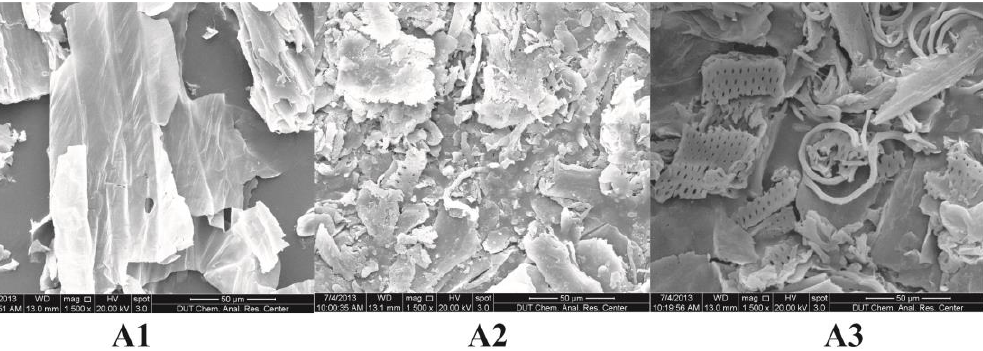
Figure 4. Characterization of the pretreated JAS. (A) SEM photo of JAS (1500×). A1, raw JAS; A2, NaOH-pretreated JAS; A3, CO-pretreated JAS.